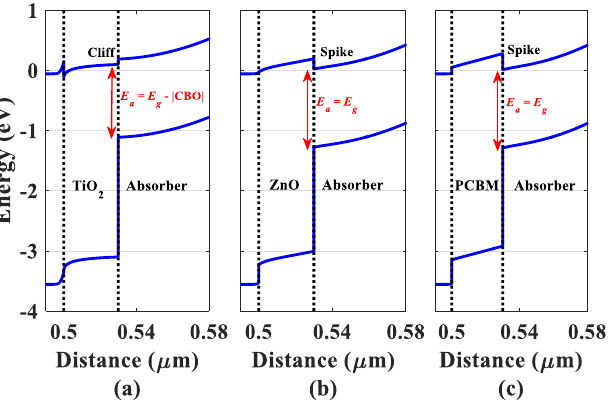
Figure 18. The energy band diagrams of the hybrid hetero-homojunction HTL-free PSC for three cases: ( a ) CBO = − 0.09 eV, ( b ) CBO = 0.17 eV and ( c ) CBO = 0.27 eV.